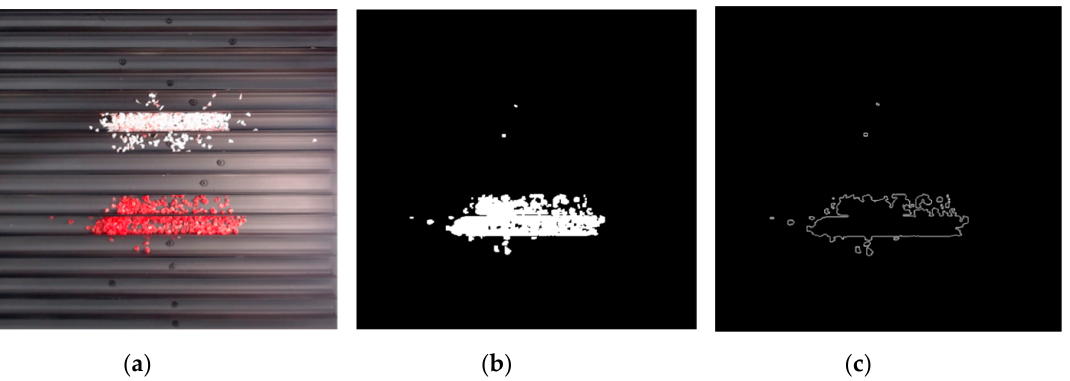
Figure 7. Raw image ( a ), effect of filtration ( b ) and calculated dispersion ( c ) for determined ranges of HSV parameters for PMMA.